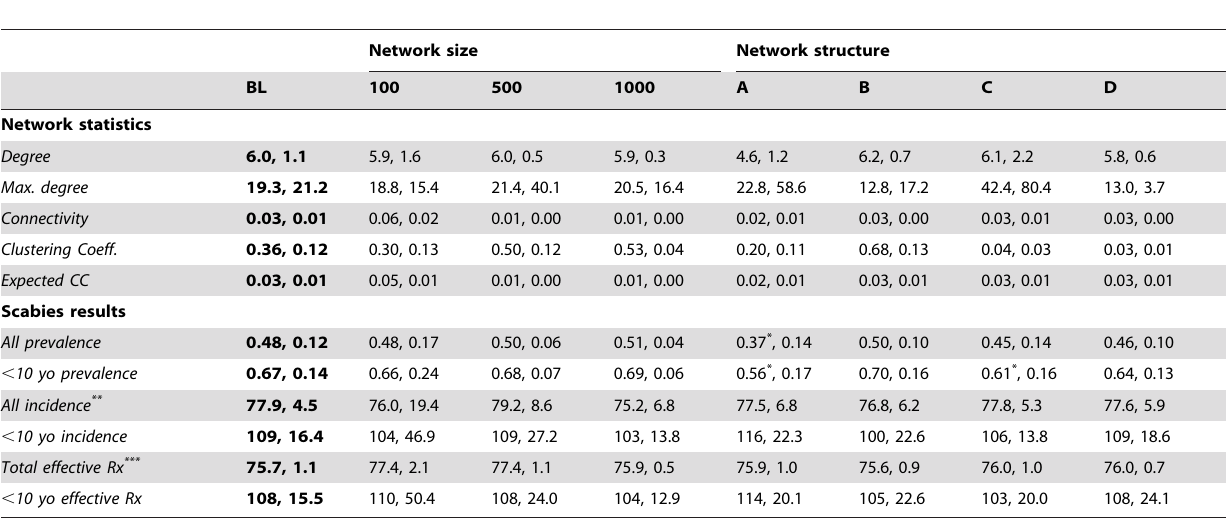
Table 2. Scenario 2 – treatment regime based on treating three index cases, without treating any first-degree contacts, every seven days ( Q =5 6 10 2 1.5